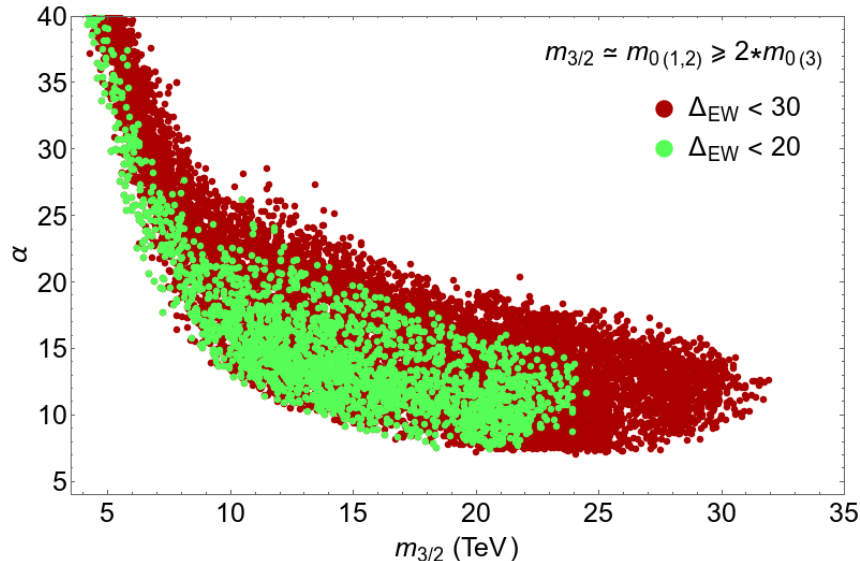
Figure 6 . Allowed SUSY solutions in the (cid:11) vs. m plane of the natural mini-landscape model with 3 = 2 other parameters scanned over as described in the text. We take c m = (16 (cid:25) 2 =(cid:11) ) 2 and c m 3 < c m = 4 & 2 m to enforce m 0 (1 ; 2) ’ m 0 3 = 2